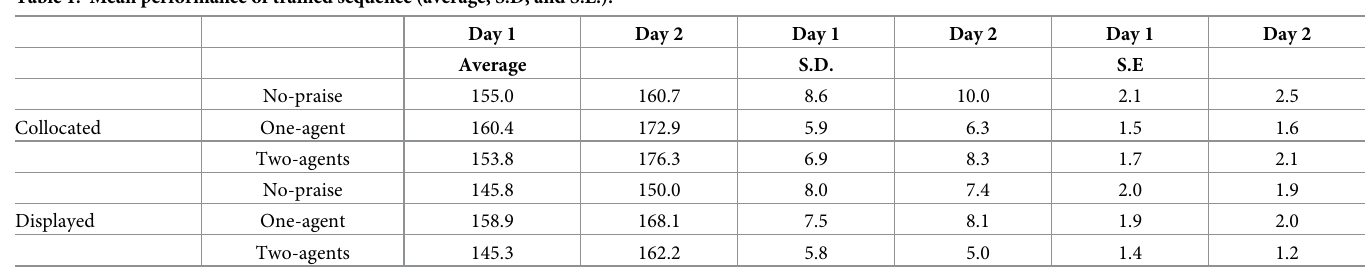
Table 1. Mean performance of trained sequence (average, S.D, and S.E.).